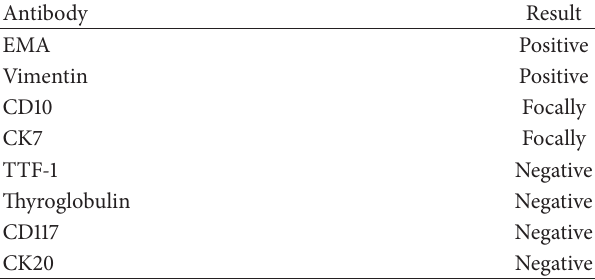
Table 1: Immunohistochemical profile of the renal